Question: Describe this figure in one sentence.
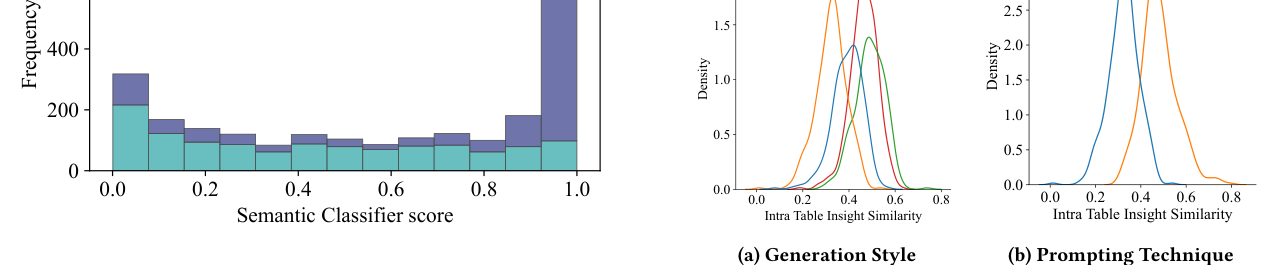
Answer: Distribution of semantic alignment scores among the executable and non-executable question code pairs stacked after one after another.